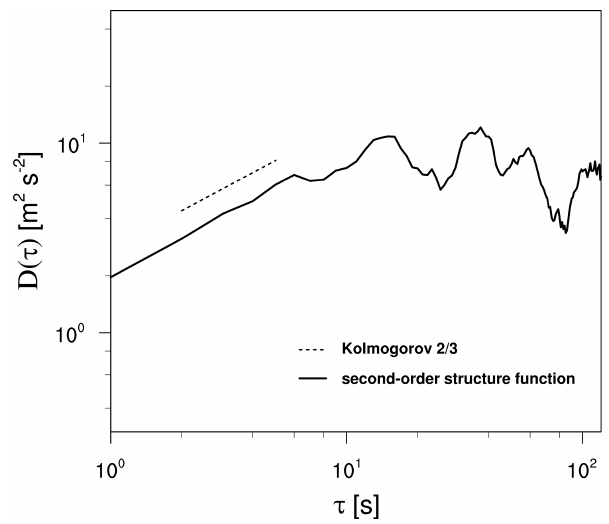
Figure 3. Example of the second-order structure functions of the meridional wind component obtained from the QAR data for 2min (starting from 11:28UTC on 11 October 2012) when strong turbu- lence (DEVG = 5.555ms − 1 ) was observed. The dashed line rep- resents the theoretical Kolmogorov inertial range slope τ 2 / 3 in the time